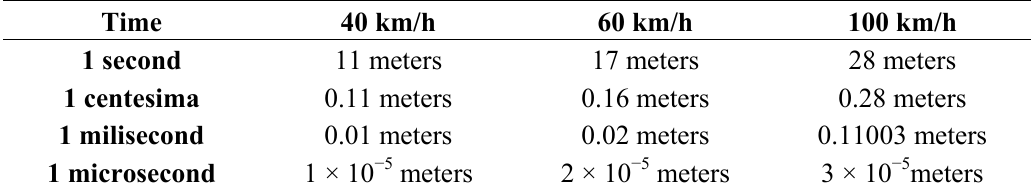
Table 1. Travelled distance related to velocity.